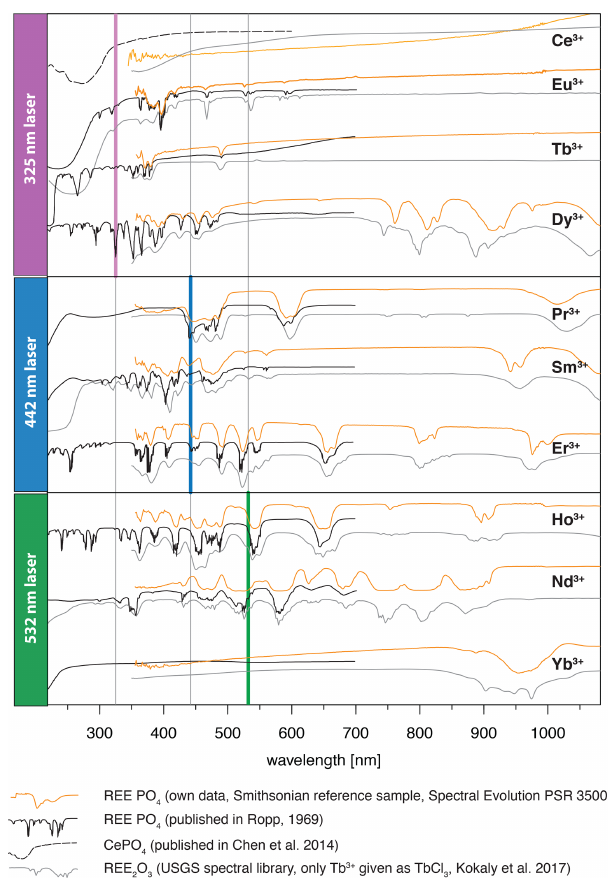
Figure 8. Graphical representation of employed excitation laser wavelengths compared to reflectance spectra from our own mea- surements of the same REE PO 4 reference samples using a Spectral Evolution PSR 3500 and two published data sets of reflectance spec- tra (for reference details see figure legend, y axis given in arbitrary units for illustration